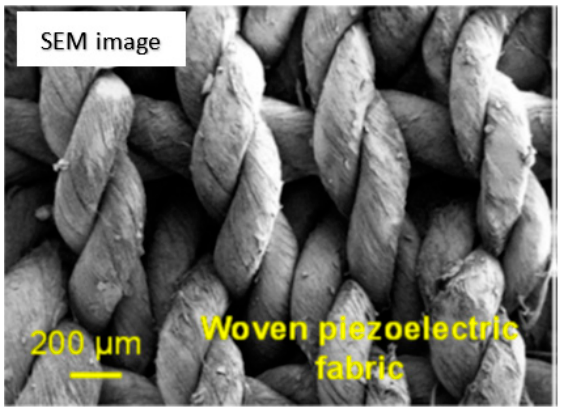
Figure 5. SEM image shows the microstructure of a woven piezoelectric fabric obtained using the plied yarns. Reprinted with permission from Enlong Yang, Zhe Xu, Lucas K. Chur, Ali Behroozfar,